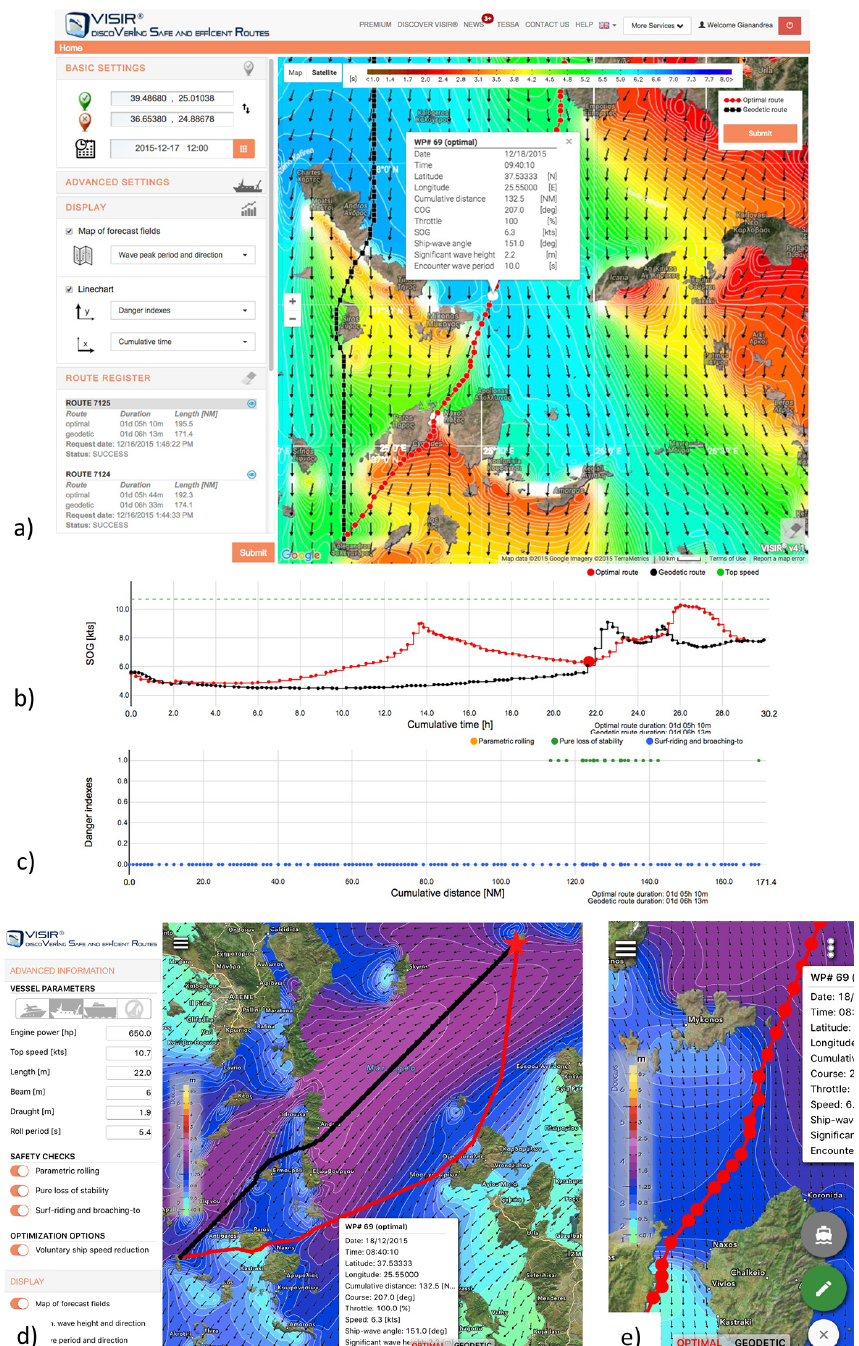
Figure 7. A motorboat route computed by VISIR. A displacement vessel with parameters as in Table 1 is employed for the computations. Panels (a) , (b) , and (c) belong to the web application; panels (d) and (e) to the iOS mobile app respectively on an iPad and iPhone. The shaded field in (a) is the peak wave period (see footnote no. 8 on p. 3) and wave direction, while the shaded field in (d) and (e) is significant wave height and wave direction. Panels (b) and (c) are two possible visualizations of the line chart below the map of the web application: in (b) the SOG vs. cumulative time since departure and in (c) the danger index vs. cumulative distance from departure place is visualized. See Sect. 7 for the availability of input and output data relative to this